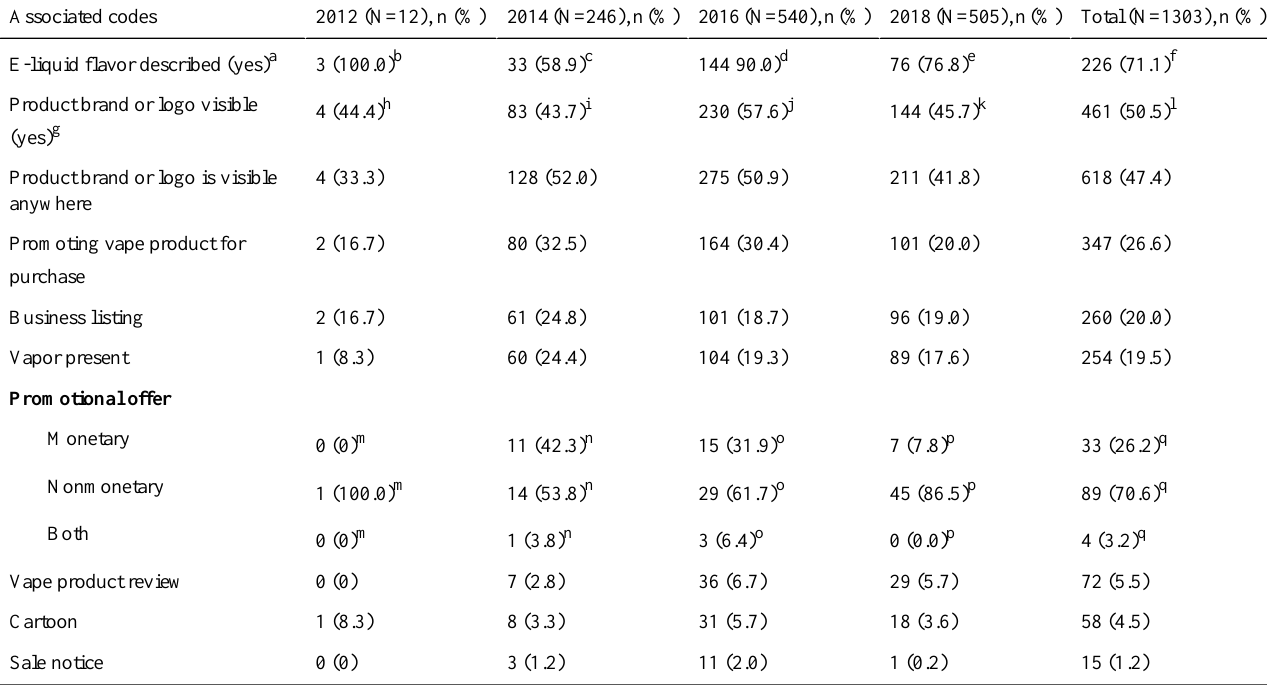
Table 4. Frequency statistics for each year corpus and the total sample within the “promotional practices and strategies”